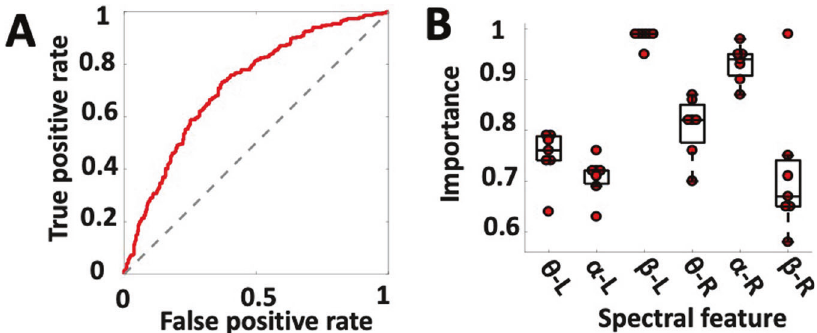
Fig. 2 Acute changes in brain electrophysiology following exposure to intraoperative SCC-DBS. A Logistic regression classi fi er with elastic- net regularization discriminated between baseline (PRE) and post-stimulation (POST) LFPs in the SCC region, AUC mean = 0.729; SD = 0.034, N = 7. B A feature importance score indicated the relative contribution of features to classi fi er success (PRE vs.